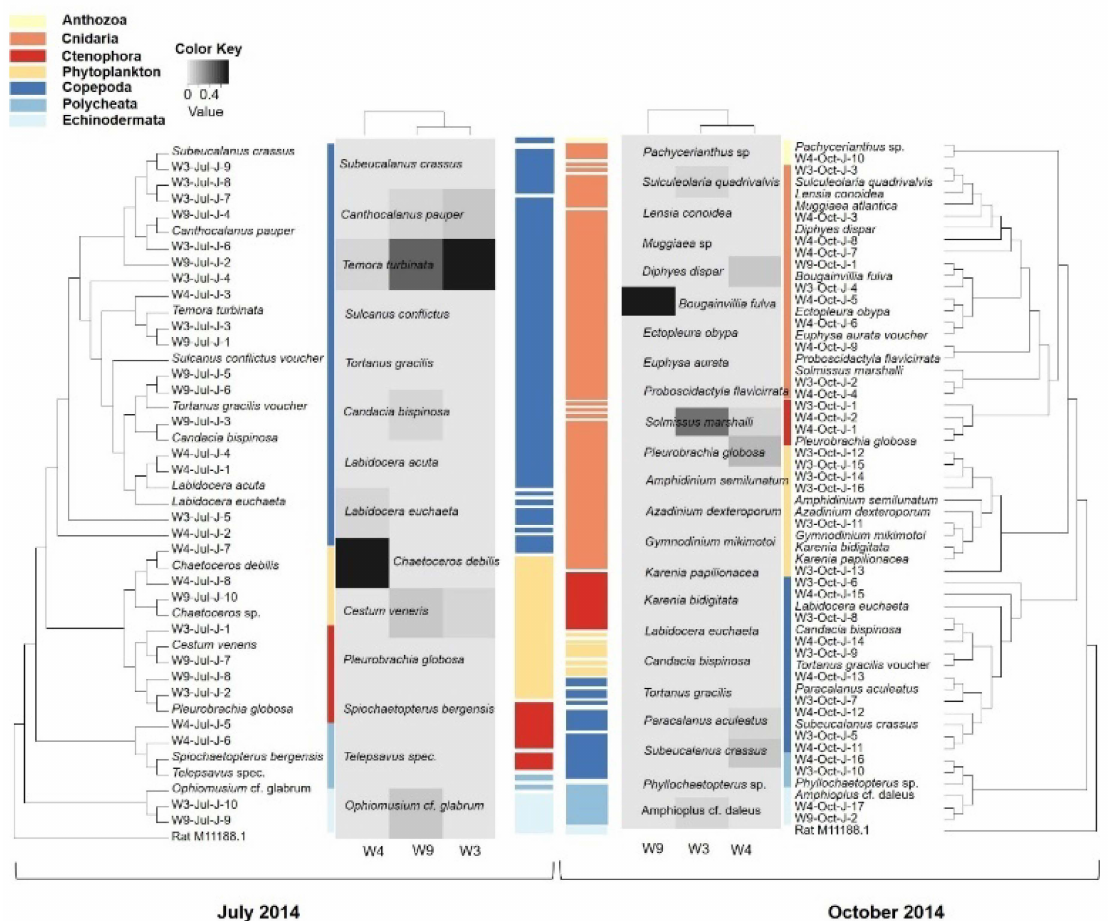
Figure 3. Phylogenetic a ffi liations, heatmap and composition of the diet organisms of juvenile F. enflata in two seasons. Maximum Likelihood (ML) tree was inferred from 780 bp fragment of the 18S rDNA amplified from the